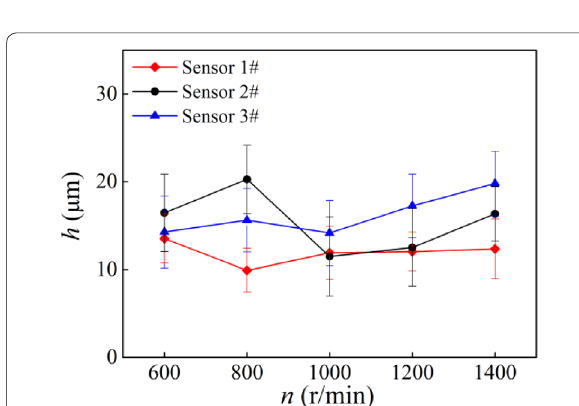
Figure 11 Change of the oil film thickness with the pressure at the conversion region from high pressure to low